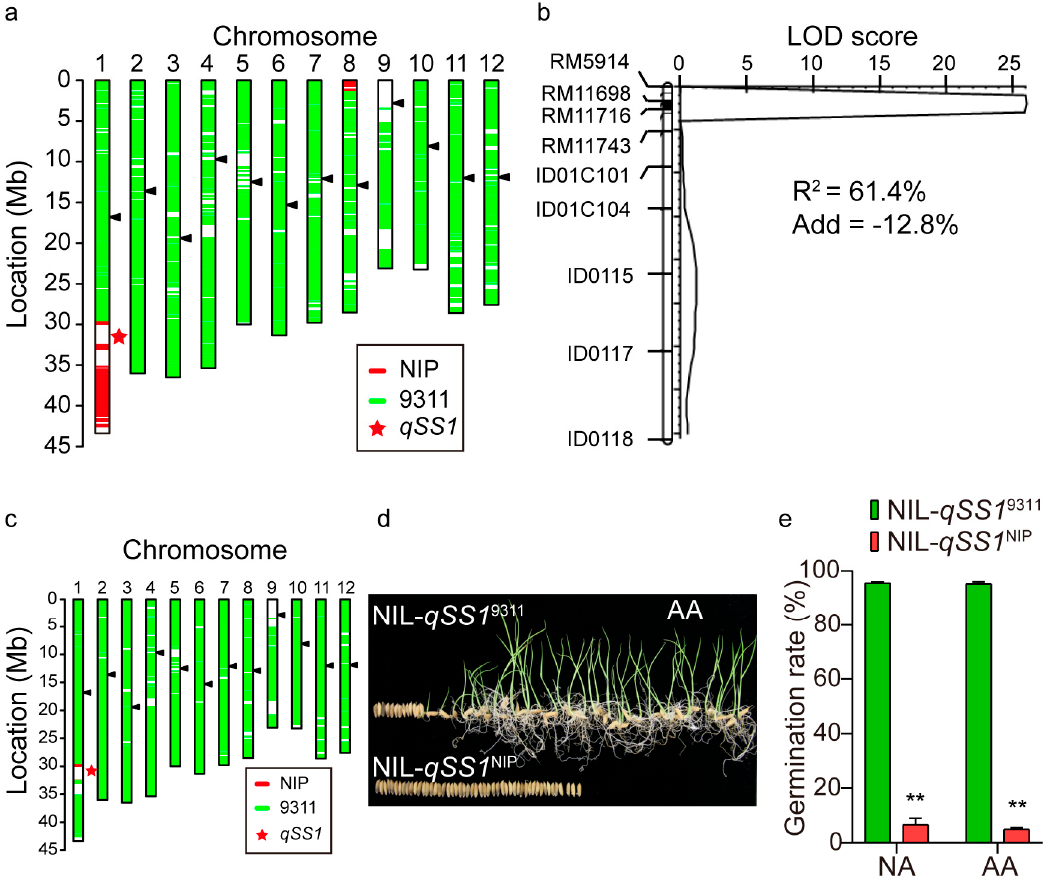
Figure 3. Validation of qSS1 . ( a ) Graphic genotype of one line that carries an introduced NIP segment encompassing qSS1 . Arrowhead (black) indicates centromeric region. ( b ) qSS1 is narrowed down to the interval flanked by the markers RM11698 and RM11716 using a derived F 2 population ( n = 128). ( c ) Graphic genotype of NIL- qSS1 9311 . ( d, e ) Seed germination of NIL- qSS1 9311 and NIL- qSS1 NIP after natural aging and artificial aging. NA and AA denote natural aging and artificial aging, respectively. Double asterisks in ( e ) indicate significant difference between NILs at p < 0.01.